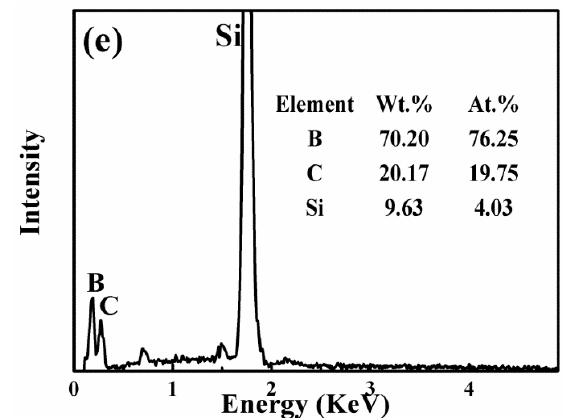
Figure 3. Low-magnification image of polished morphology of ( a ) SiC/SiC and ( b ) SiC/SiC-SiBC; High-magnification scanning electron microscope (SEM) images of ( c ) SiC/SiC-SiBC and ( d ) dense Si-B-C matrix; ( e ) the energy dispersive spectrometer (EDS) results of B 12 (C, Si, B) 3 phase.